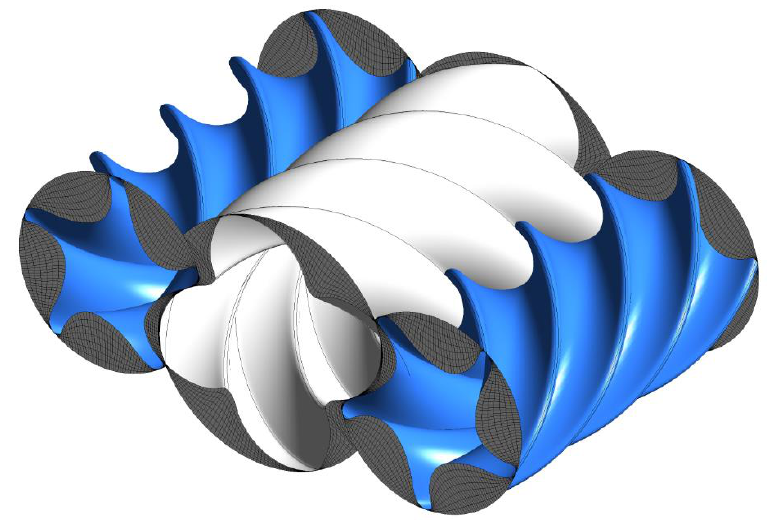
Figure 10. Tri-rotor screw compressor grid with 4/5 ‘N’ profile (Video S3).